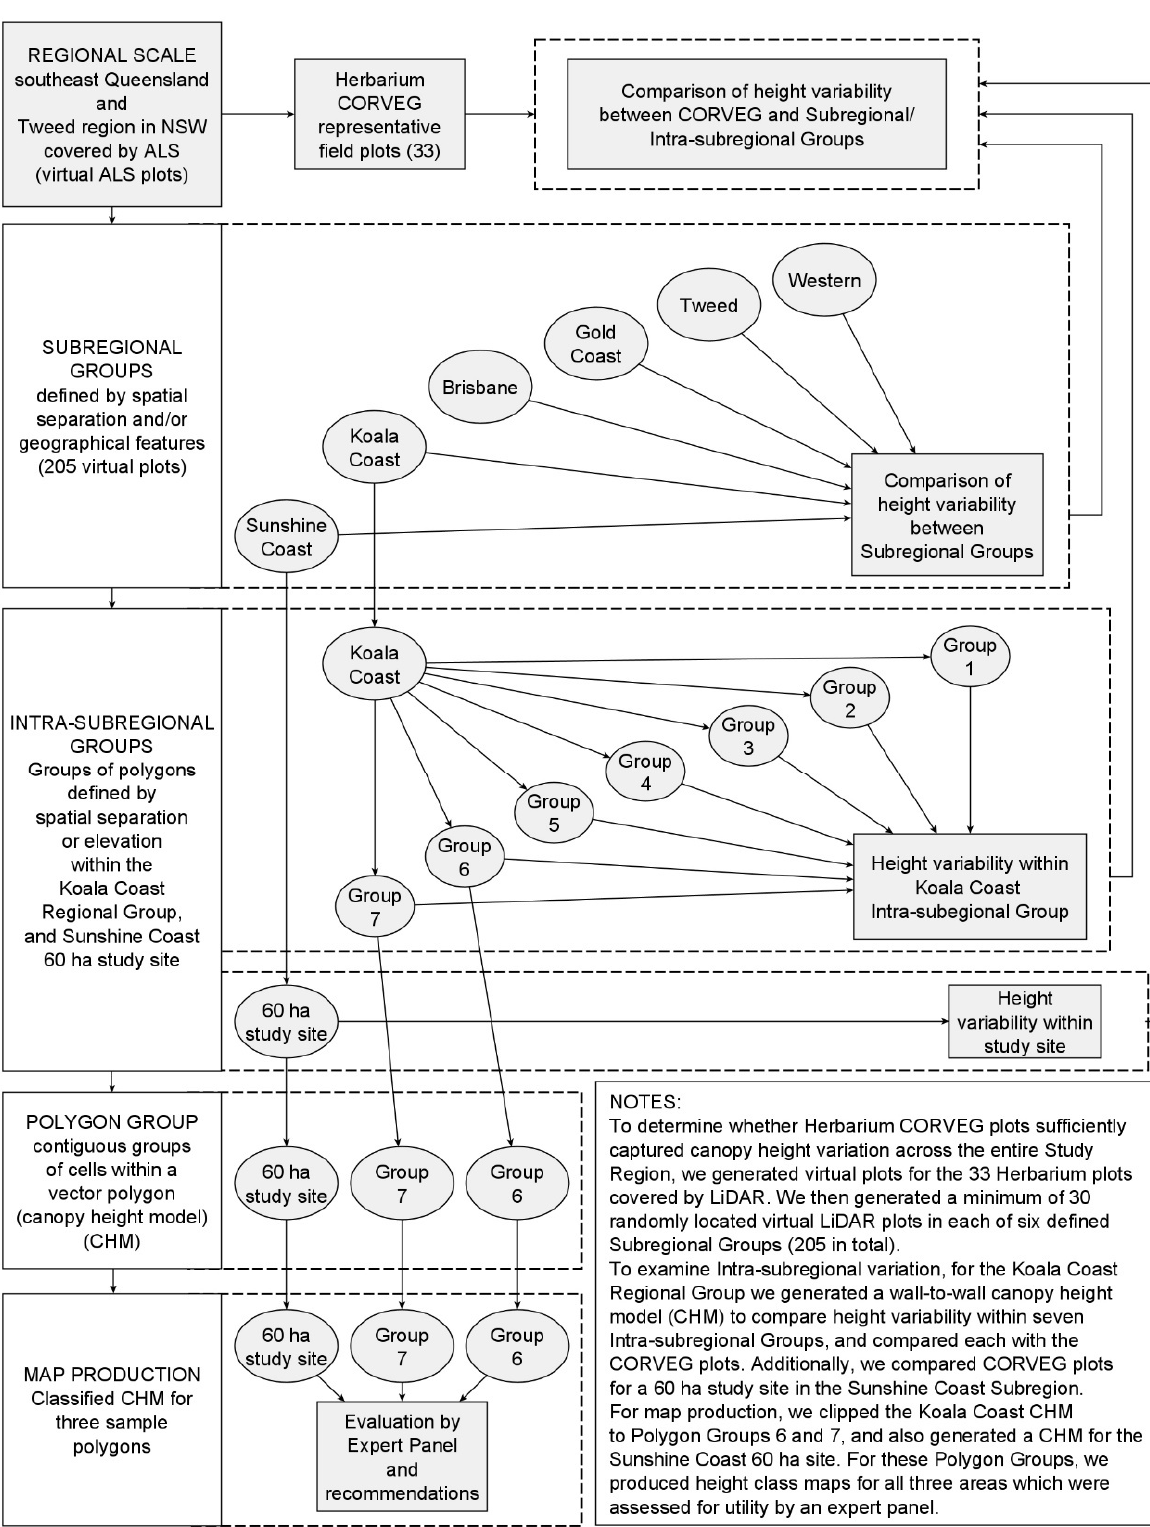
Figure 2. Workflow implemented to examine the forest height variability at the regional, subregional, and intra-subregional scales for the nominated forest community (Regional Ecosystem 12.11.3). We assessed Herbarium field plots (CORVEG) to examine how well the published information captures the height variabilities within RE 12.11.3 at these scales.